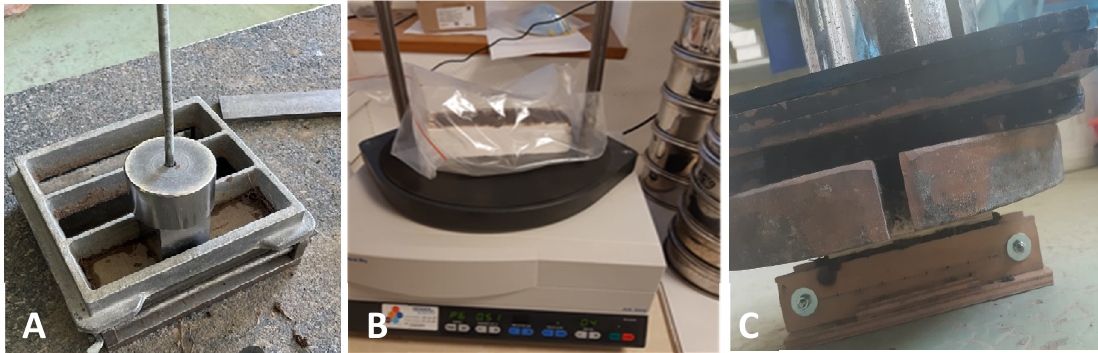
Figure 5. Compaction plane of mud bricks.